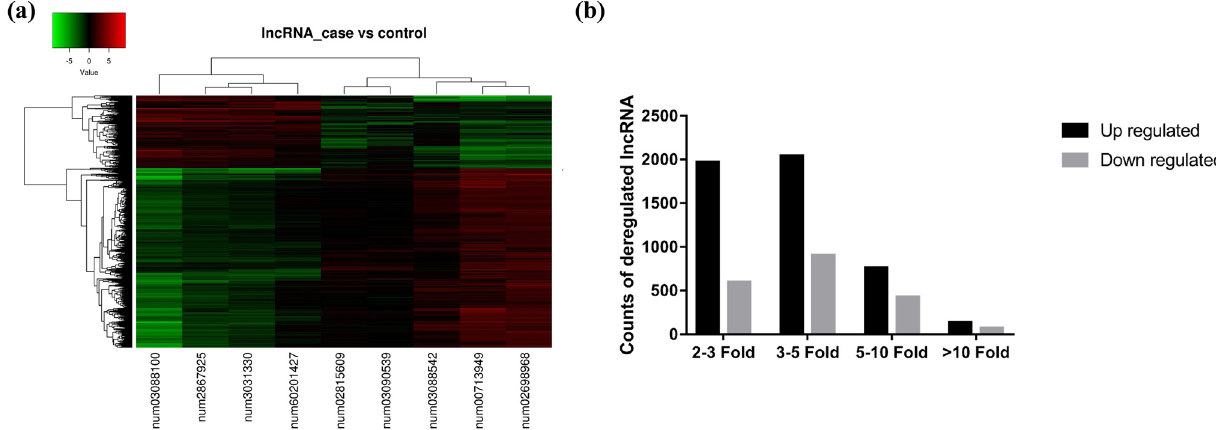
Figure 2: Microarray results of lncRNA pro fi le in idiopathic achalasia. ( a ) Heat map of di ff erentially expressed lncRNAs in idiopathic achalasia. Each row shows relative levels of expression for a single lncRNA, and each column represents the expression levels for a single sample. Colors indicate relatively high or low expression, respectively ( red is a high expression and green is a low expression ) . ( b ) Expression pro fi ling of lncRNAs in idiopathic achalasia and controls. The determination of upregulated and downregulated lncRNAs was based on more than two - fold changes in the normalized probe signal intensity in idiopathic achalasia compared to that in the control. Black columns represent the number of upregulated lncRNAs, whereas the gray columns represent the number of downregulated